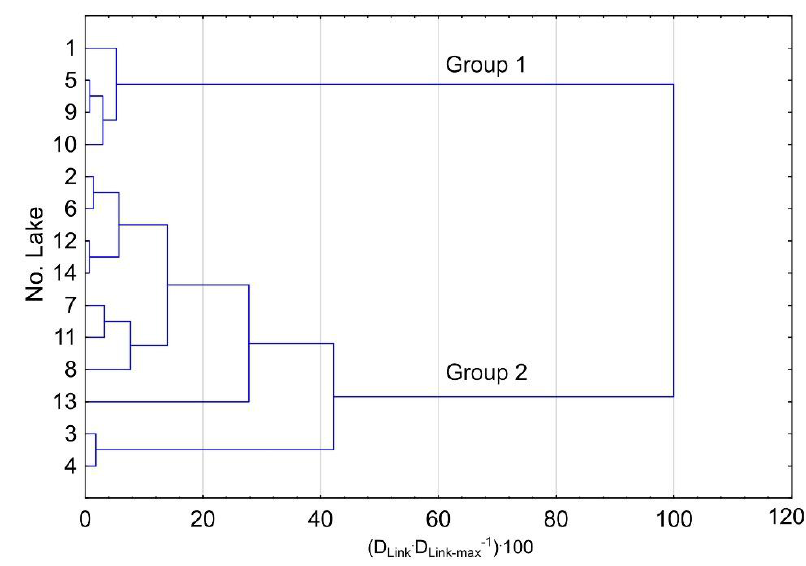
Figure 3. Grouping lakes by average annual water temperatures.